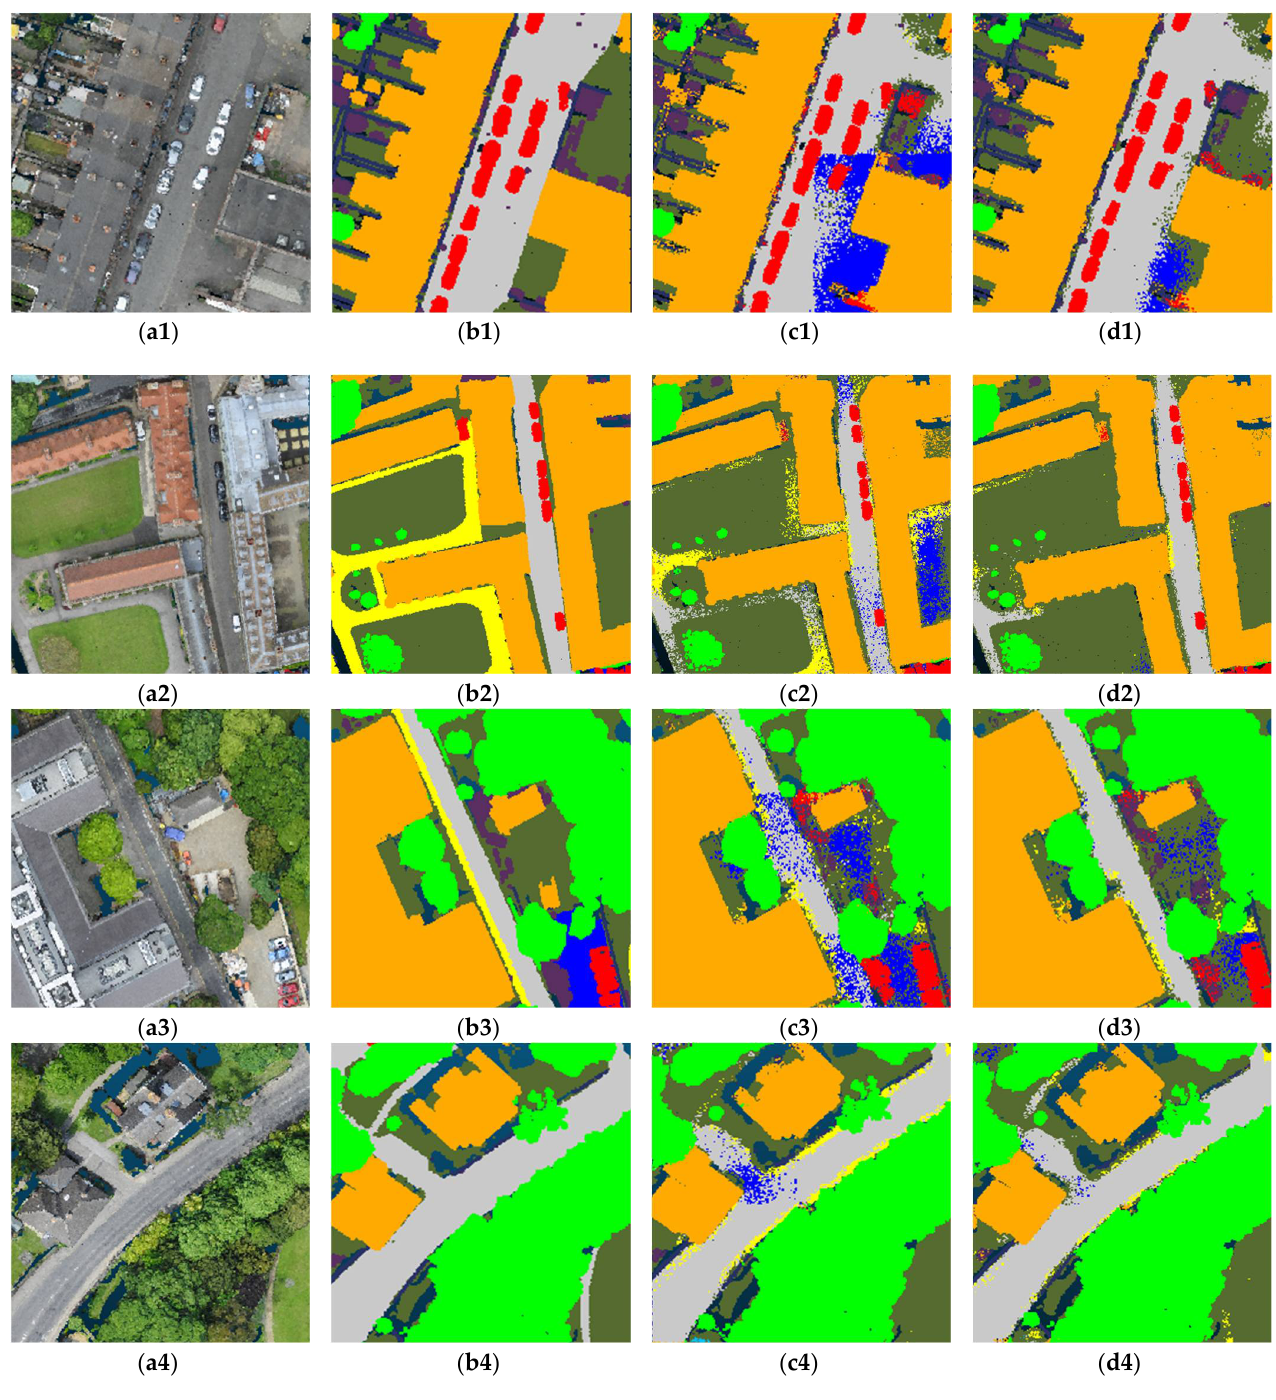
Figure 7. 3D semantic segmentation on the SensatUrban dataset. ( a1 ) Data of Scene 1. ( b1 ) Ground Truth. ( c1 ) PAConv. ( d1 ) PIIE-DSA-net. ( a2 ) Data of Scene 2. ( b2 ) Ground Truth. ( c2 ) PAConv. ( d2 ) PIIE-DSA-net. ( a3 ) Data of Scene 3. ( b3 ) Ground Truth. ( c3 ) PAConv. ( d3 ) PIIE-DSA-net. ( a4 ) Data of Scene 4. ( b4 ) Ground Truth. ( c4 ) PAConv. ( d4 ) PIIE-DSA-net.